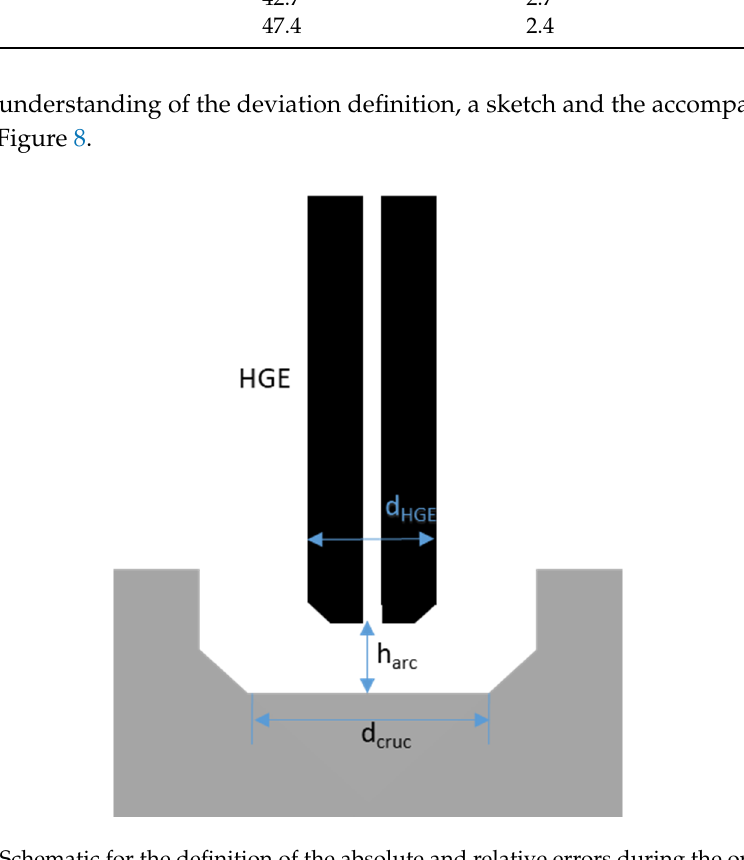
Figure 8. Schematic for the definition of the absolute and relative errors during the operation.